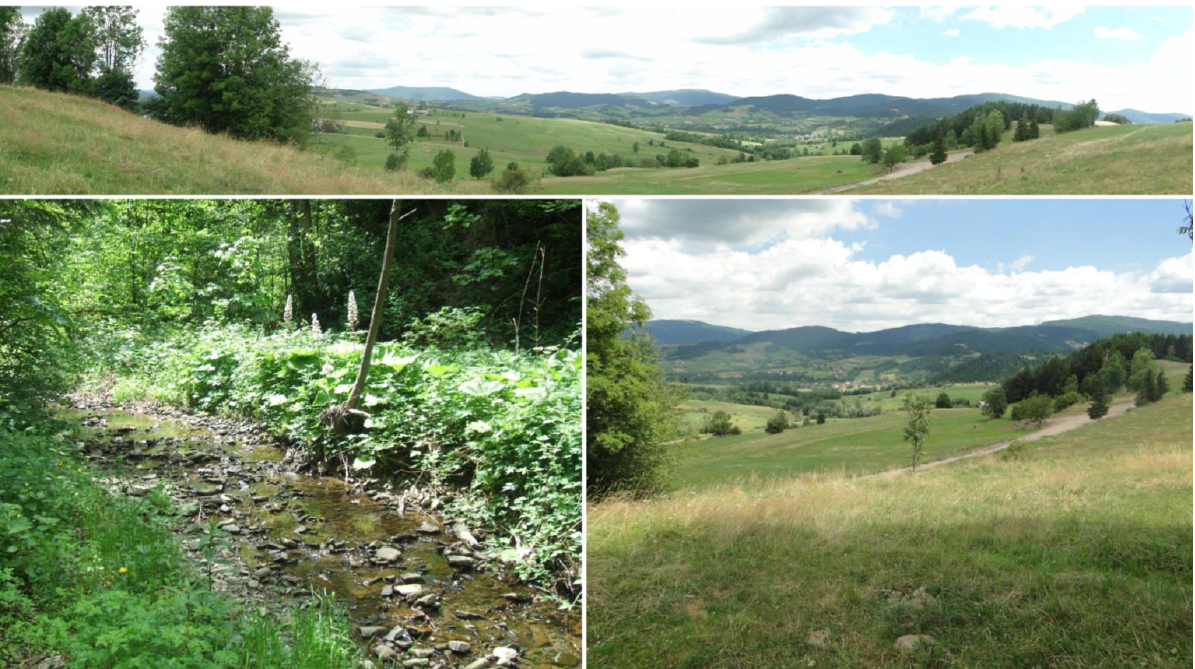
Figure 1. Location of the research area within Poland.